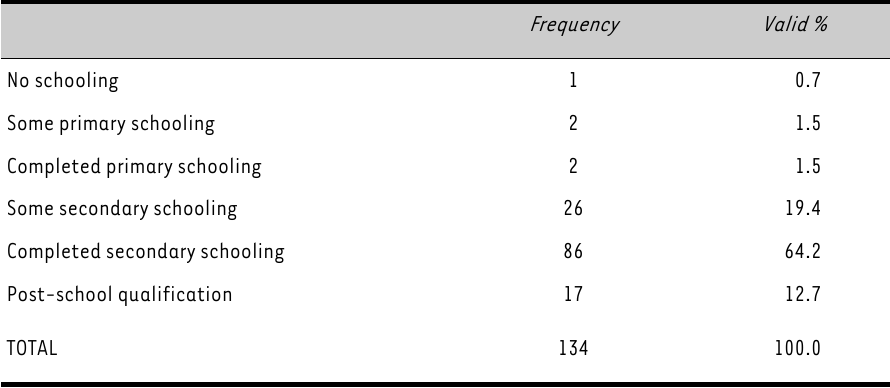
TABLE 1: Highest educational qualification of waiters in Kempton Park, 2008